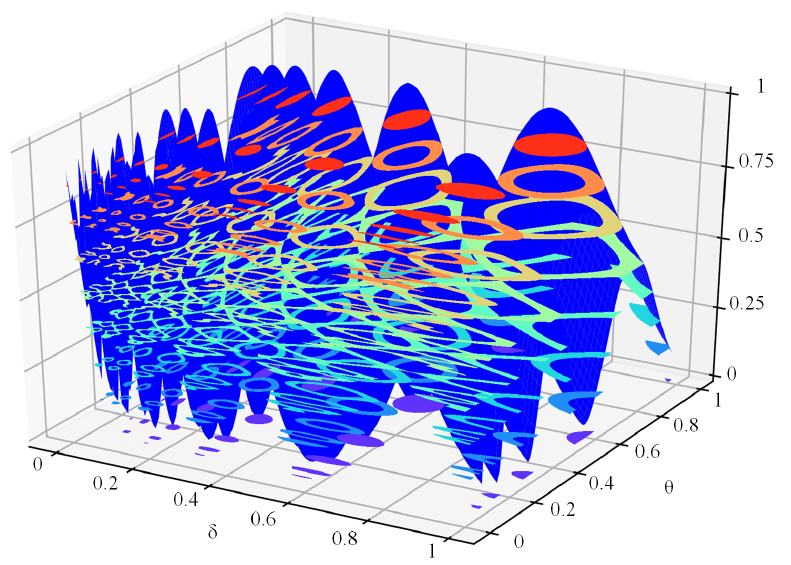
Figure 13. 3-D surface graph for scattered